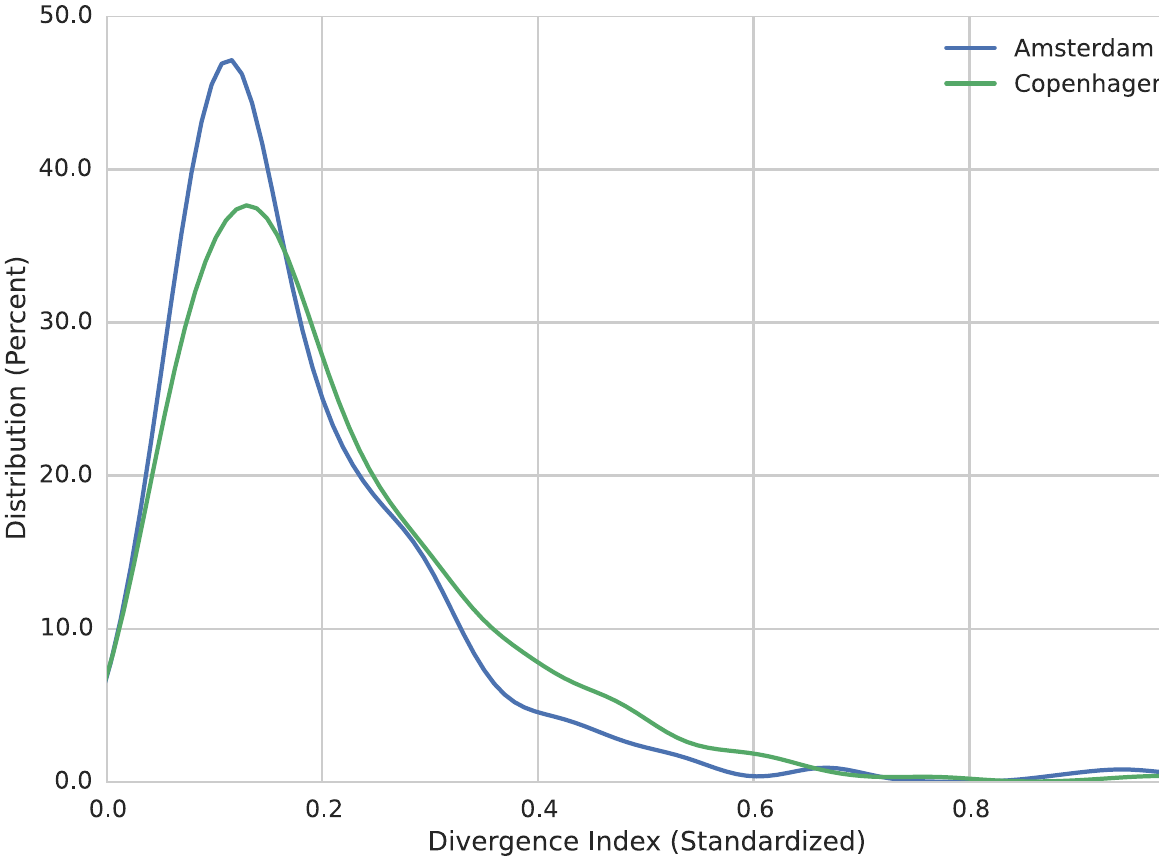
Fig 3. Distribution of divergence indices in Amsterdam and Copenhagen. The divergence index is inversely proportional to the diversity of a place. We calculate the index for each place in the two cities in our study. The graph shows the distribution of standardized